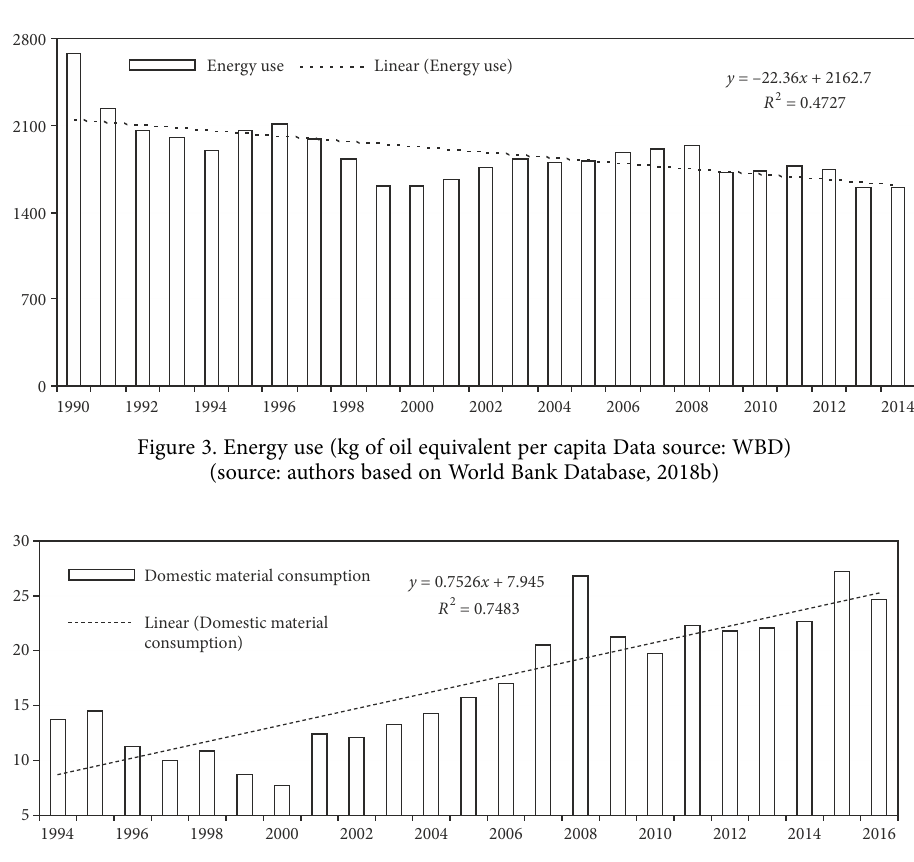
Figure 4. Domestic material consumption (tonnes per capita) (source: authors based on Eurostat,